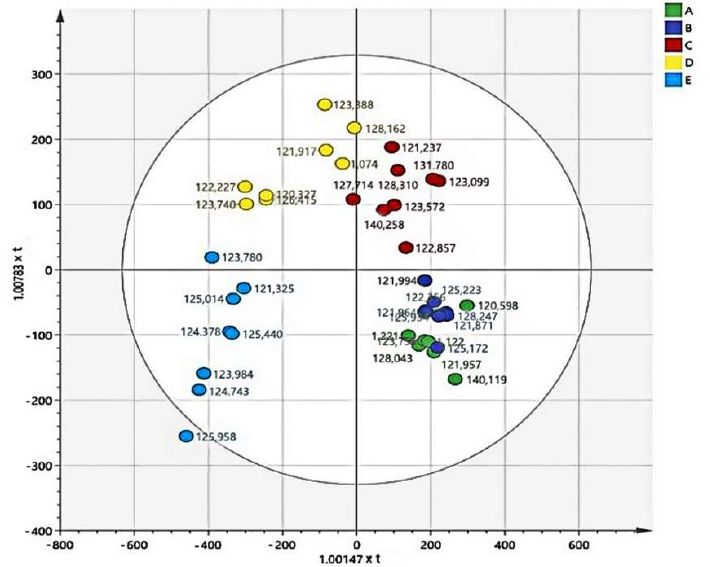
Figure 3. Principal component analysis plot for metabolites in milk detected by using LC-MS/MS. Green (A): Control group; mineral blue (B): 50Cot group; red (C): 100Cot group; yellow (D): 50CotCorn group; azure (E): 100CotCorn group.